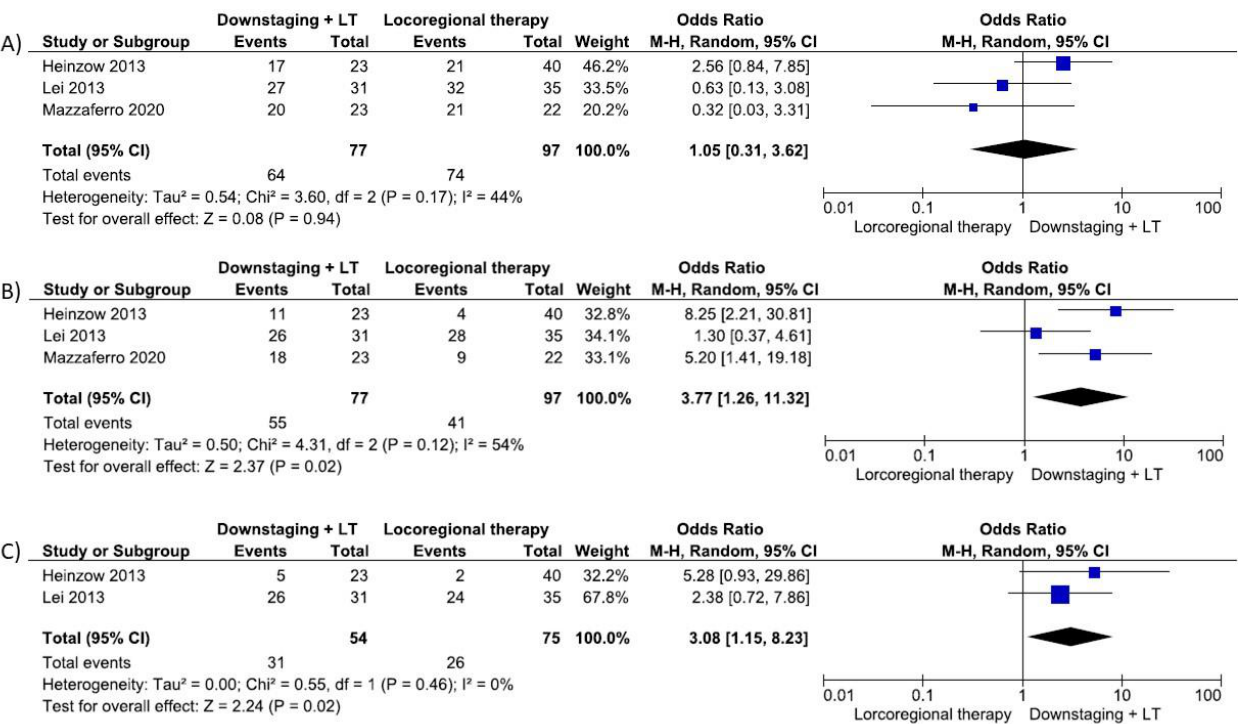
Figure 6. Question 2: Forrest plot post-downstaging survival based on ITT analysis: ( A ) 1y-overall survival; ( B ) 3y-overall survival; ( C ) 5y-overall survival. Bold: p values < 0.05.